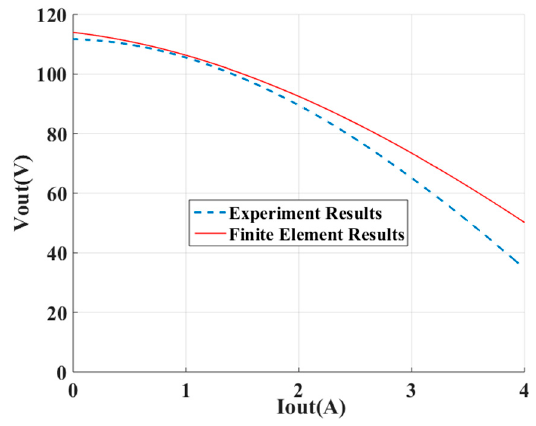
Figure 19. Variation of output voltage versus load current.